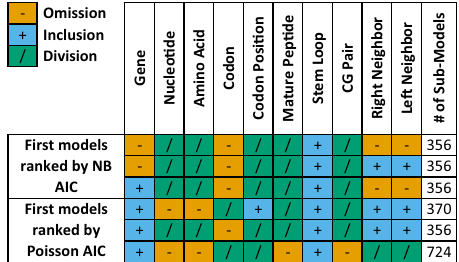
Fig. 1 Top-scoring models for the training dataset. The fi rst three rows correspond to the top-scoring models when NB regression is applied. The next three rows correspond to the top-scoring models when Poisson regression is used. Each explaining factor is either ( ) omitted from the model, ( ) used as an explanatory factor, or ( ) used to split the GLM into sub-models. We note that there are potential redundancies in the models. For example, the codon explaining factor contains the complete information on the amino acid and the nucleotide explaining factors (but not the other way). Our regression method of examining all inclusion possibilities for each factor considers this and produces a precise score regardless of the intertwined